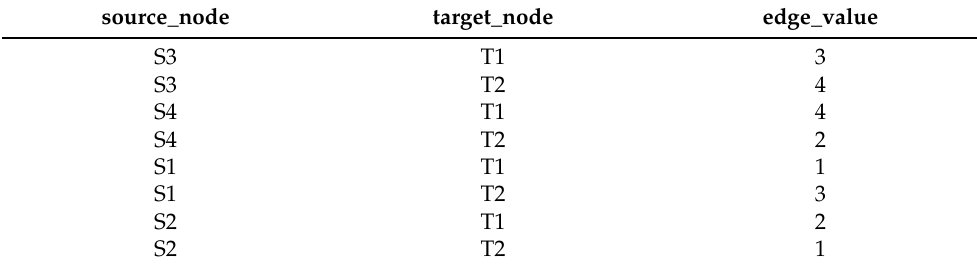
Table 2. More complex, but still relatively simple data from the second example described in Section 2.1.3. These data are visualized in Figure